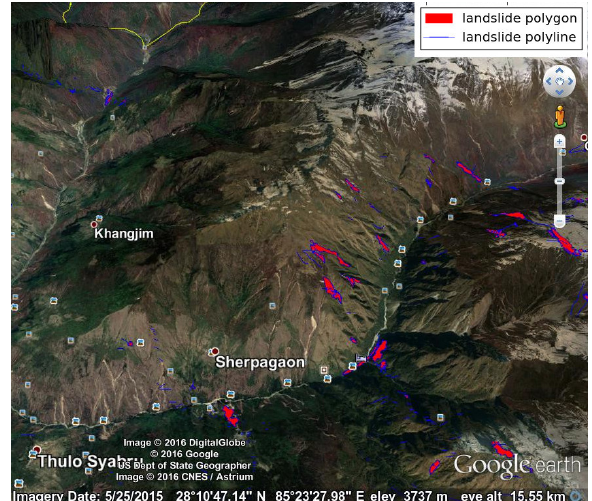
Figure 6: Landslide overlay